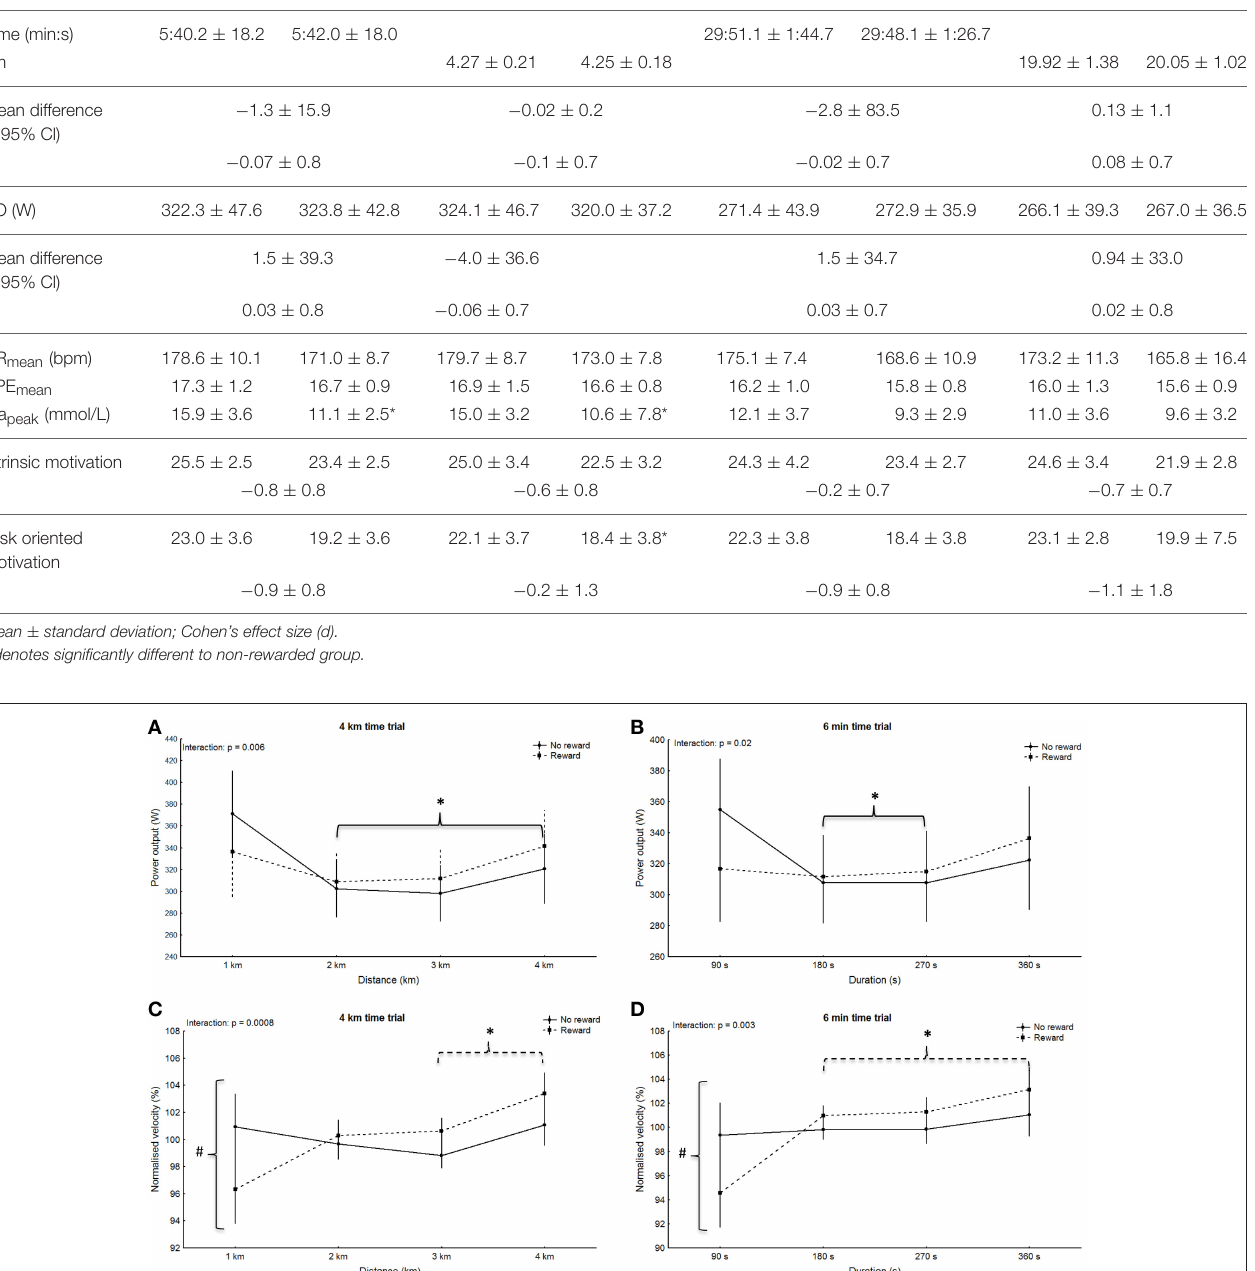
nine during the 30 min trial ( p < 0.02; Figure 2D ), whereas no difference between splits was found during the 20 km trial ( p > 0.05).